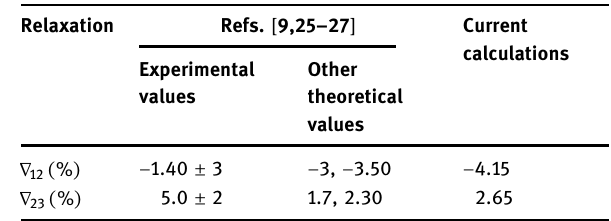
Table 1: Comparison between values of relaxation computed herein and corresponding literature values Relaxation